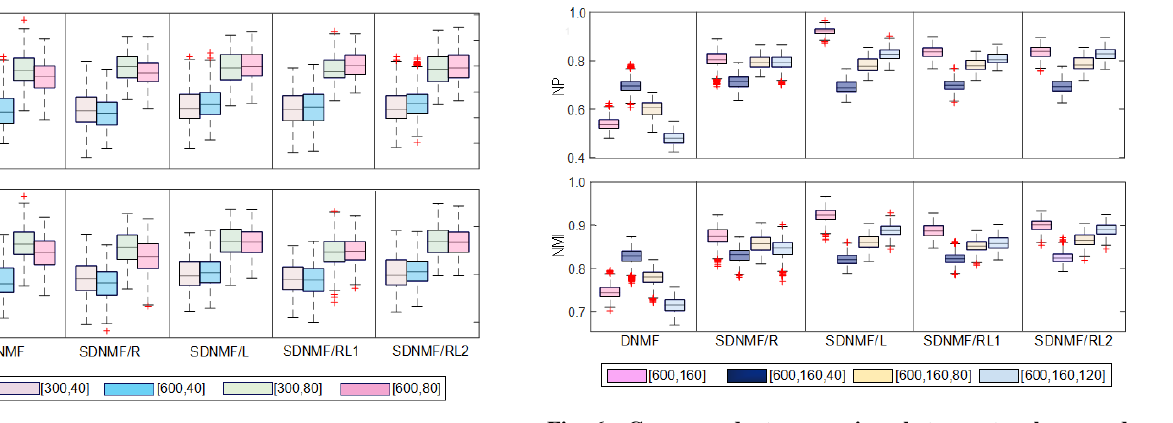
Fig. 4 k 1 selection of our proposed linear deep models on PIE-pose 27.0 dataset. Each linear model was tested under four conditions: layer size = [300, 40], [300, 80], [600, 40], and [600, 80].